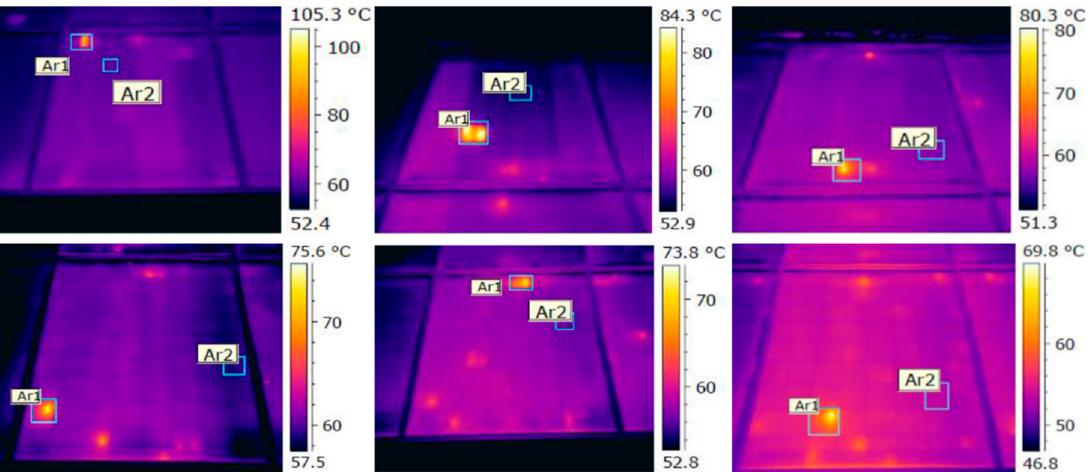
Figure 10. Thermographs of six selected modules, all of which presented grave or medium failures. The areas whose temperatures were compared are shown in the pictures and labelled as Ar1 (for anomaly) and Ar2 (for background).